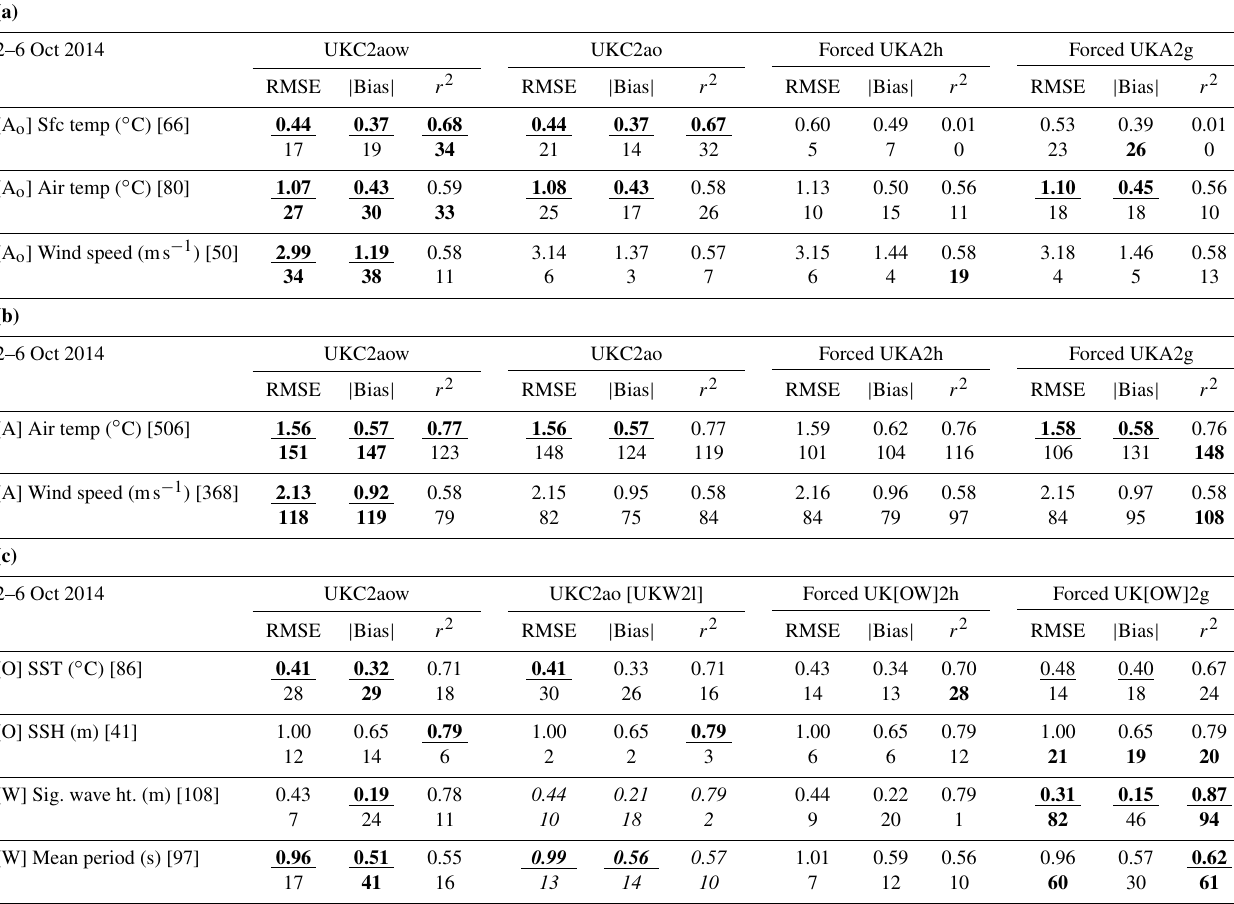
Table 6. Summary RMSE, bias and r 2 correlation coefficient statistics for the 2–6 October 2014 case study. Average statistics are computed from a comparison of model output against in situ observations of (a) atmosphere [A o ] model variables over sea grid cells only, (b) all atmosphere [A] model variables, and (c) ocean [O] and wave [W] model variables. The relevant forced configuration with high-resolution forcing UKW2h, UKO2h and UKA2h are treated as the reference control model. Results showing a statistically significant difference from the reference according to a t test at the 95% confidence level are underlined. Those also showing an improvement against the reference are also in bold. Also listed for each variable under the horizontal lines for each metric is the number of sites for which the model configuration provided the best statistic relative to the other model configurations tested for this case. The configuration with the highest number of sites listed is highlighted in bold. Numbers in square brackets show the number of observation locations assessed for each